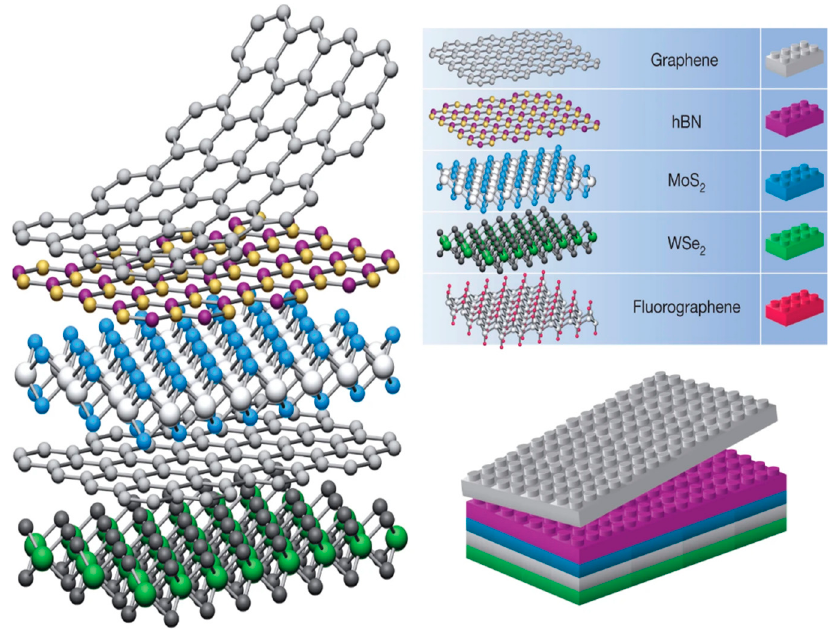
Figure 1. Structure of van der Waals heterostructures, similar to that of Legos. Reprinted (adapted) from reference [17], copyright (2013) Springer Nature.